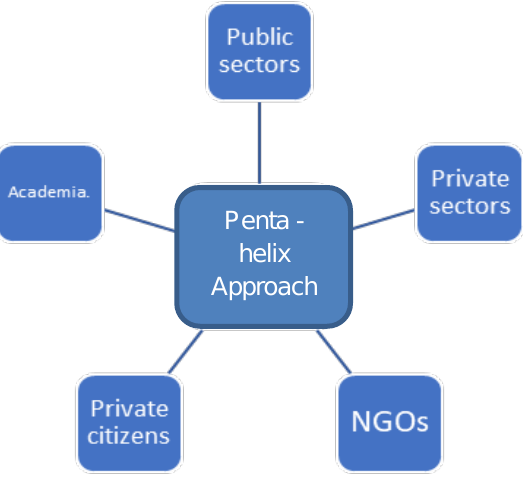
Figure 1: Penta Helix Approach in the Creation of